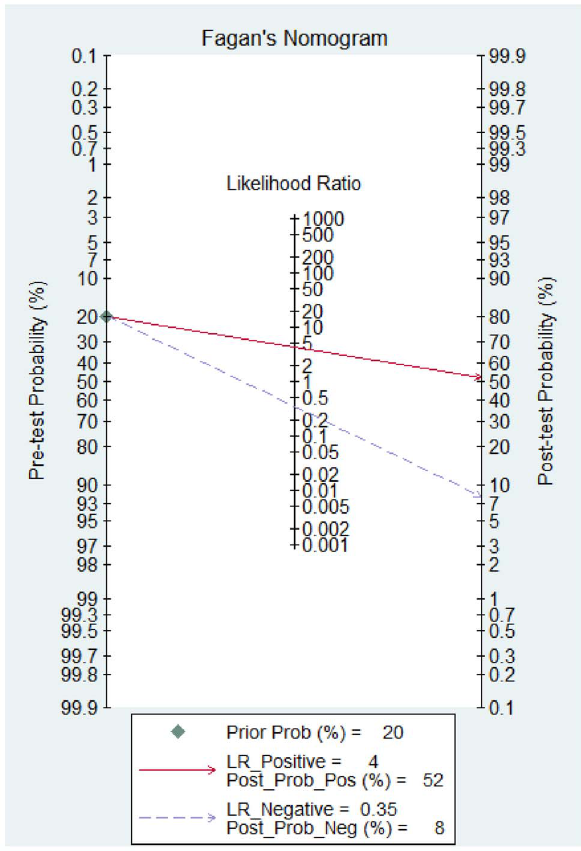
Figure 4. Fagan’s Nomogram for assessment of post-test probabilities (PTPs).